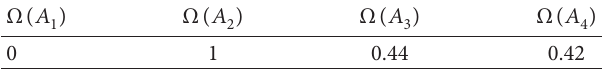
Table 6: Overall prospect dominance degrees.